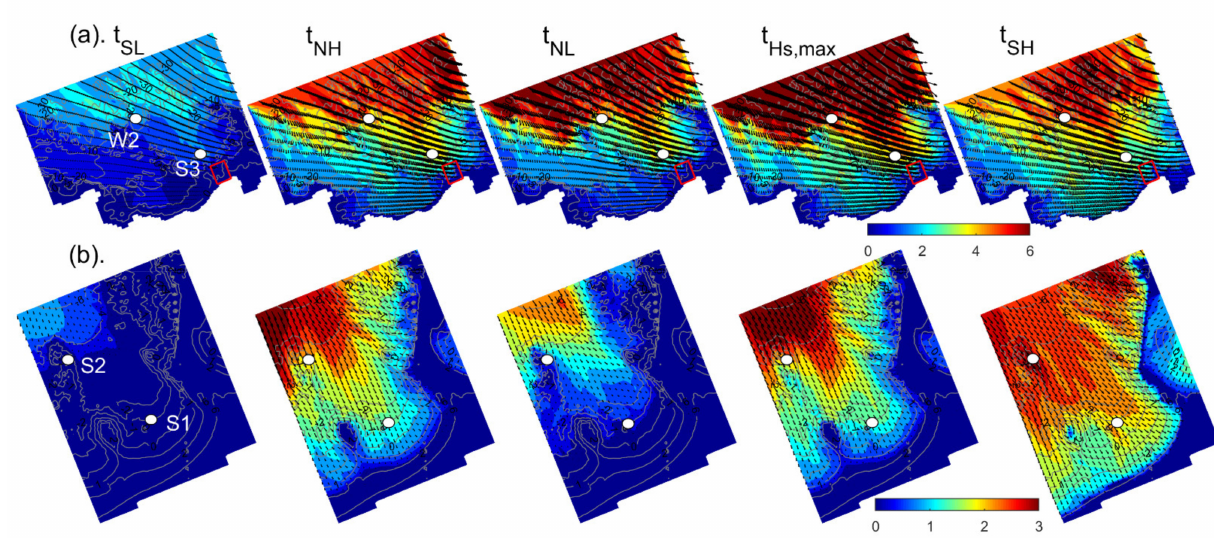
Figure 6. Wave height (color) and direction (vectors) in the G2 ( a ) and G3 ( b ) model domains at the selected five dates, t SL : spring-low water, t NH : neap-high, t NL : neap-low, t Hs,max : peak storm wave height, t SH : spring-high. S1, S2, and S3 indicate the locations of the pressure sensors, and W2 indicates the location of the wave time series obtained from WW3. The red rectangles in ( a ) show the location of the G3 domain.